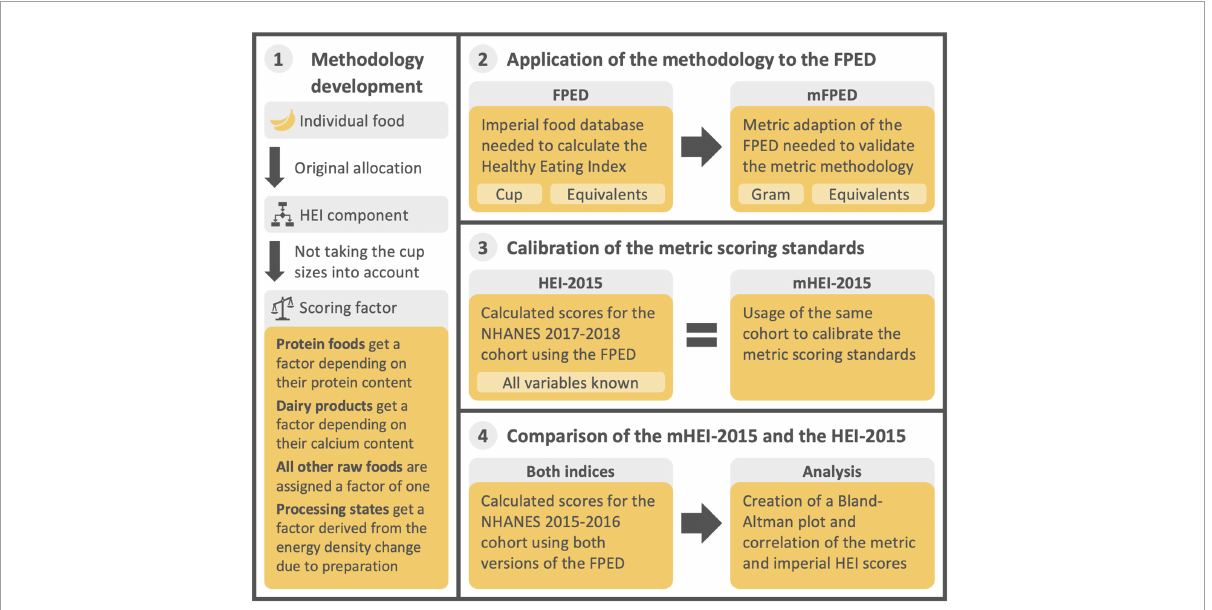
FIGURE1 Graphical summary of the methodological approach and the corresponding data basis for the development and comparison of the mHEI-2015. HEI, Healthy Eating Index, FPED, Food Patterns Equivalent Database, mFPED, metric Food Patterns Equivalent Database, mHEI-2015, metric Healthy Eating Index-2015, NHANES, National Health and Nutrition Examination